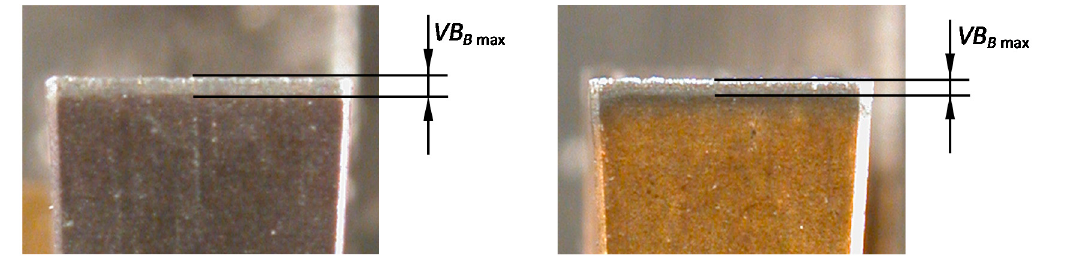
Figure 3. Tool flank wear measurement for different inserts.